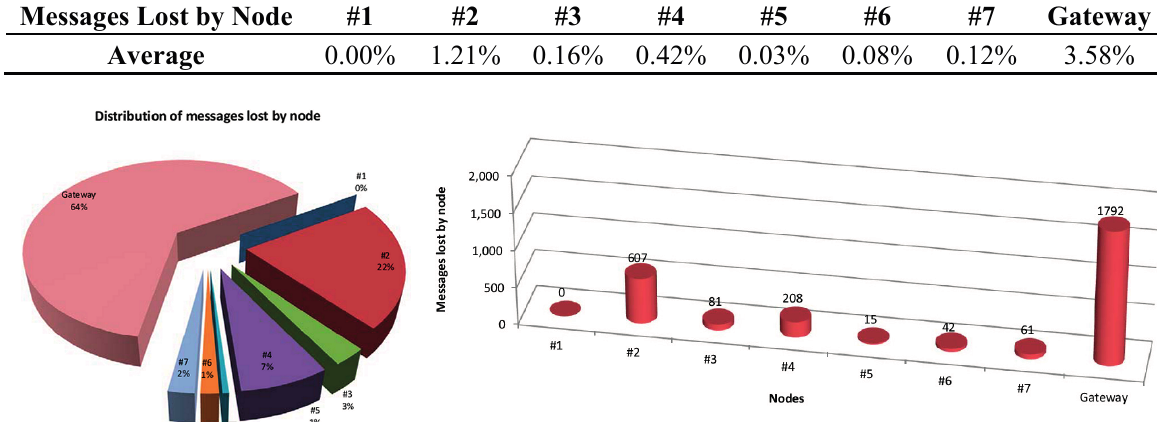
Figure 19. Distribution of messages lost by